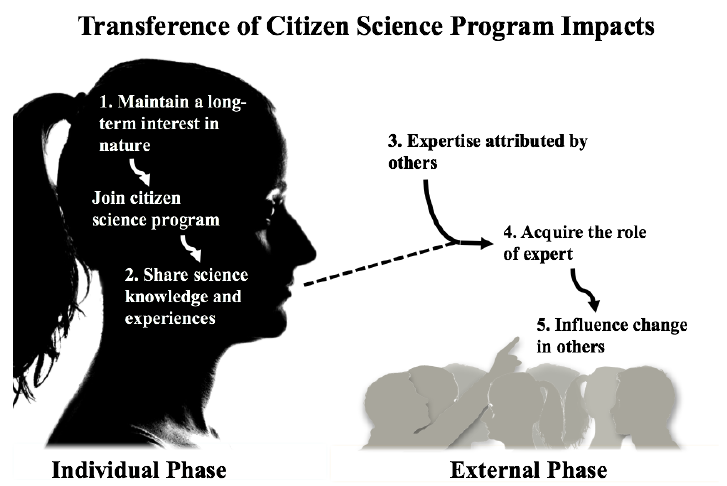
Figure 2. Several individual and external actions must occur for transference of citizen science program impacts to be achieved. Table 3. Conceptual categories (actions) of transference with supporting data, artifacts, and repre- sentative quotes. An expanded table is provided in the Supplementary Files.